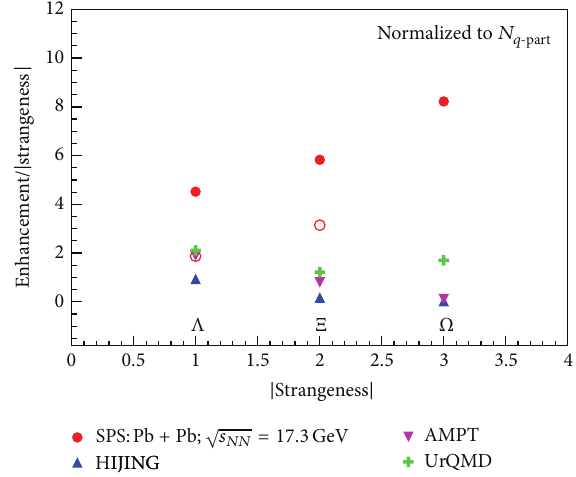
Figure 14: Midrapidity 𝑁 𝑞 and strangeness content normalized -part enhancement of multi-strange baryons as a function of strangeness content for Pb + Pb collisions at √𝑠 𝑁𝑁 = 17.3 GeV at SPS. The filled and open circles are for the particles and the antiparticles,